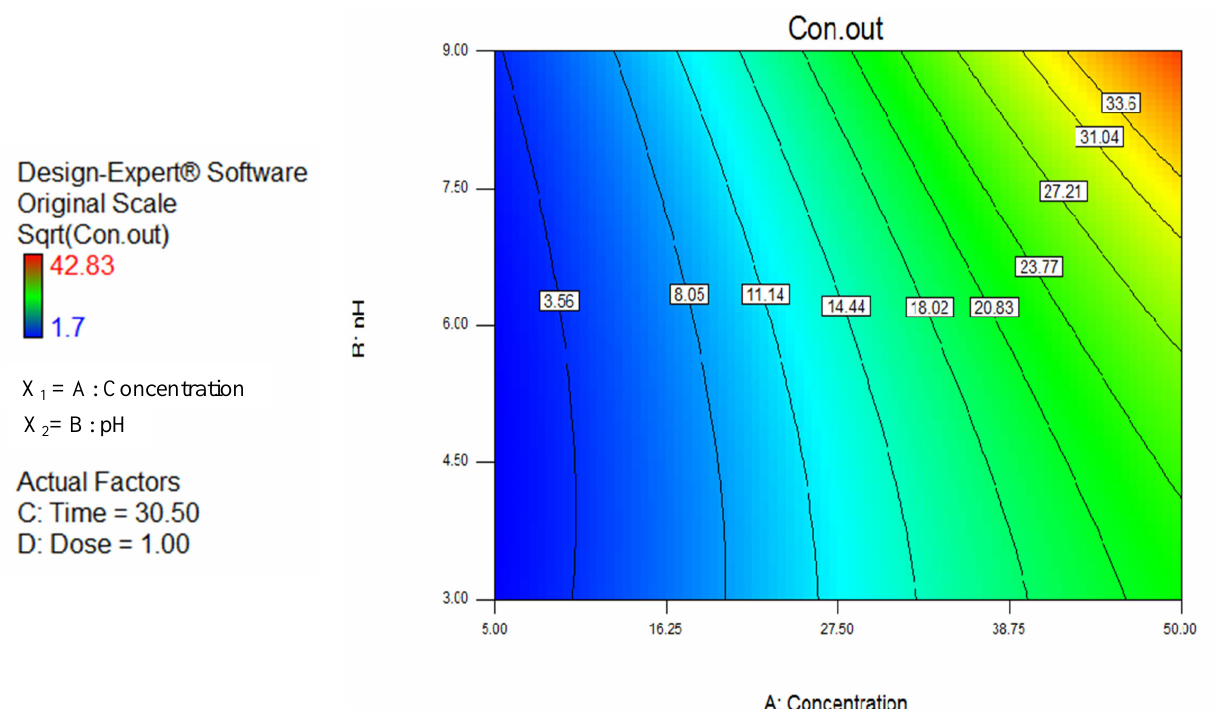
Figure 4. Response surface contour plots showing effect of initial concentration (mg HA/l) and pH on humic acid (HA) removal (mg/l)